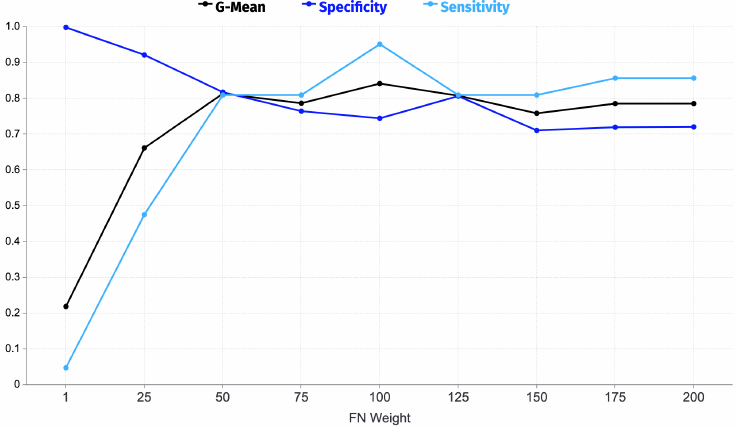
Figure 6. The effects of FN prediction weight on g-mean, specificity, and sensitivity when using the cost-sensitive MHOANN with the PSO for the dataset of Spanish companies.